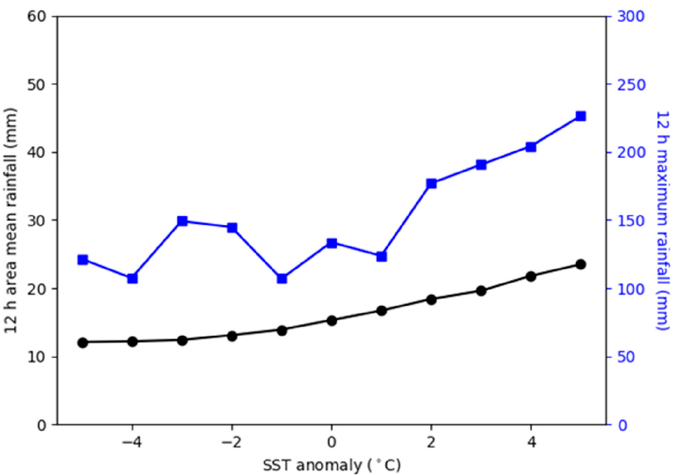
Figure 31. 12 h area mean accumulated (black) and maximum accumulated rainfall (blues) in mm